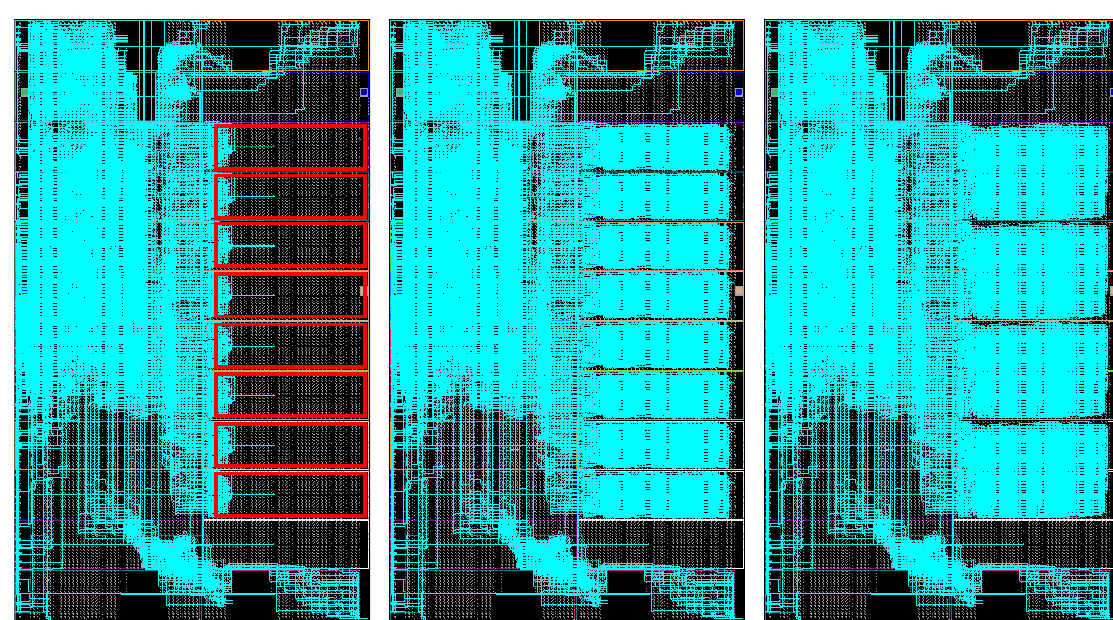
Figure 9. FPGA floorplanning of an ARTICo 3 -based system in the HiReCookie node.